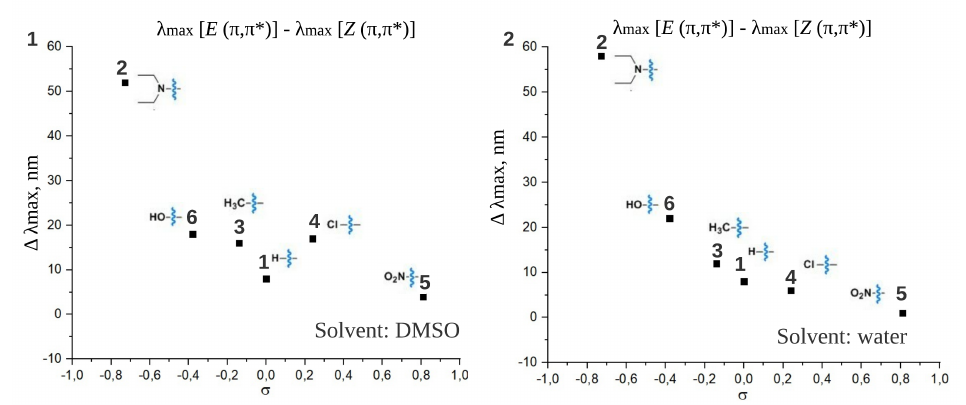
Figure 6. The dependence of spectral shift between absorption band maxima of E and Z forms of ATPLs ( ∆ λ max = λ E max - λ Z max ) for the ( π , π ∗ ) transitions on the Hammett constants of substituents ( σ ) in DMSO ( 1 ) and water ( 2 ).